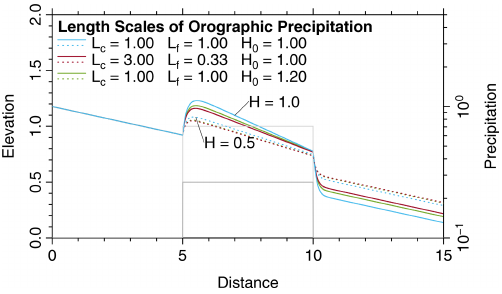
Figure 2. Effect of L c and L f , where L l (at sea level) and the prod- uct L c L f were kept constant. The solid lines refer to the original scenario ( H = 1) and the dashed lines to a reduced topography ( H = 0 . 5). The results for L c = 1 and L f = 3 are practically the 3 same as for L c = 3 and L f = 1 3